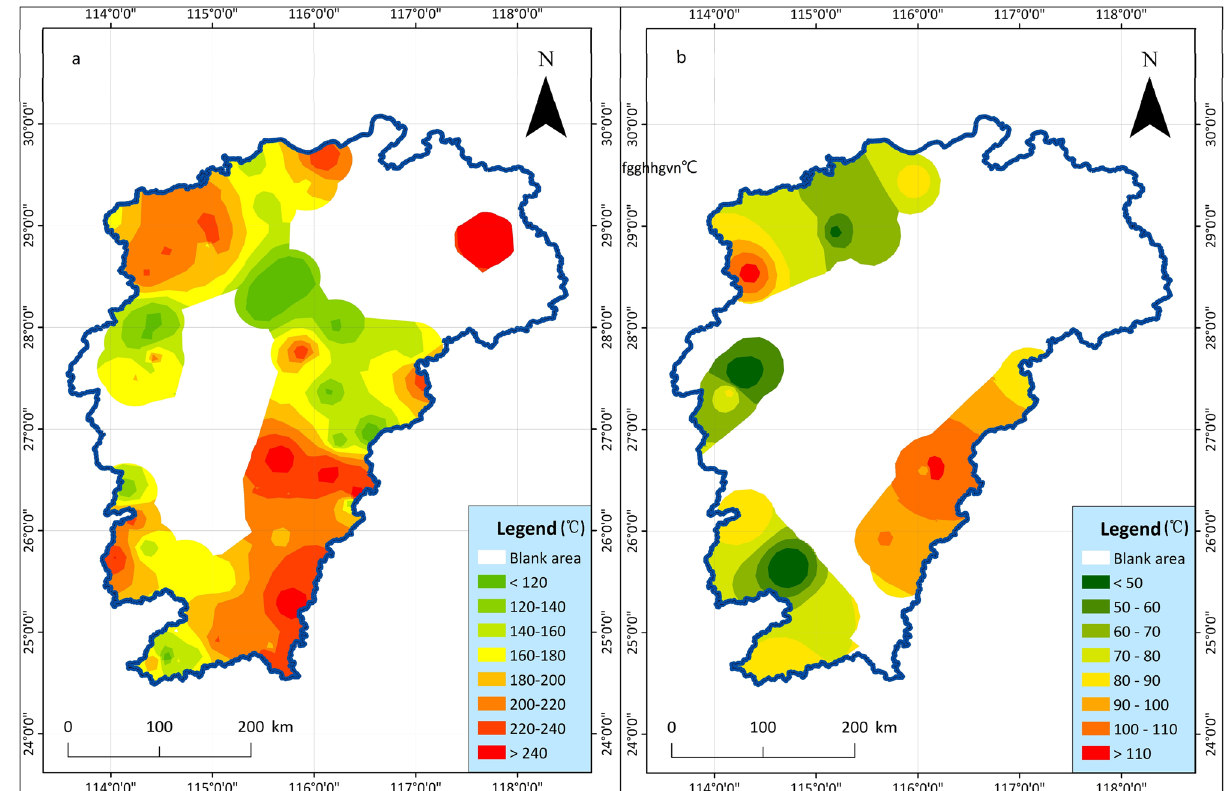
Figure 2. Displaying the thermal storage temperature distribution map is a comparison of two thermal storage calculation methods. ( a ) The thermal storage temperature distribution map of silicon enthalpy Eq. 45 heat storage value. ( b ) The thermal storage temperature distribution map of K/Mg cation temperature scale 46 heat storage